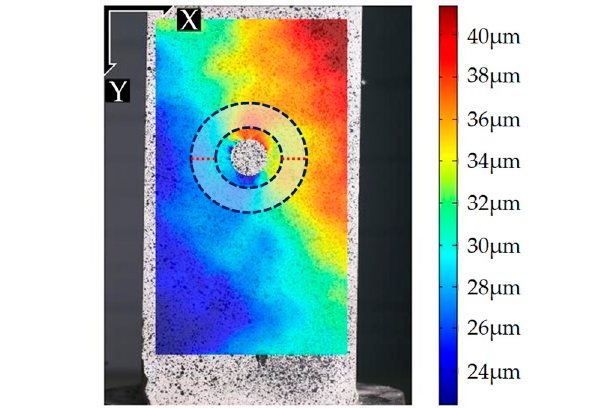
: The FEM results in zero displacements on the red dotted lines. Figure 8. The displacement field obtained by the DIC for Test 5. Figure 8. The displacement field obtained by the DIC for Test Figure 8. The displacement field obtained by the DIC for Test 5.